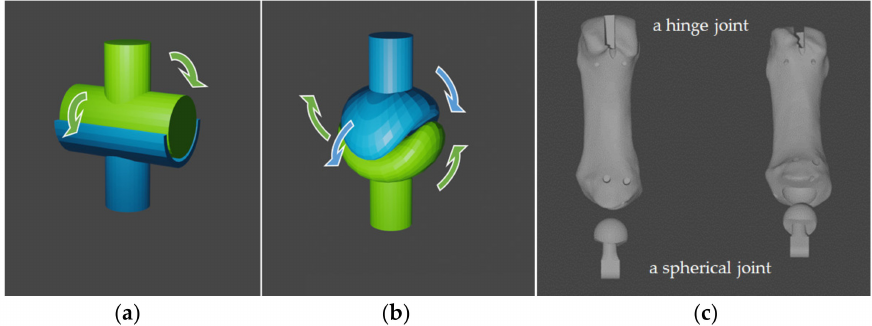
Figure 2. Finger joints schematic diagram: ( a ) hinge joint; ( b ) saddle joint; ( c ) metacarpal of thumb model with a ball and socket joint part (left: front view, right: oblique downward view).